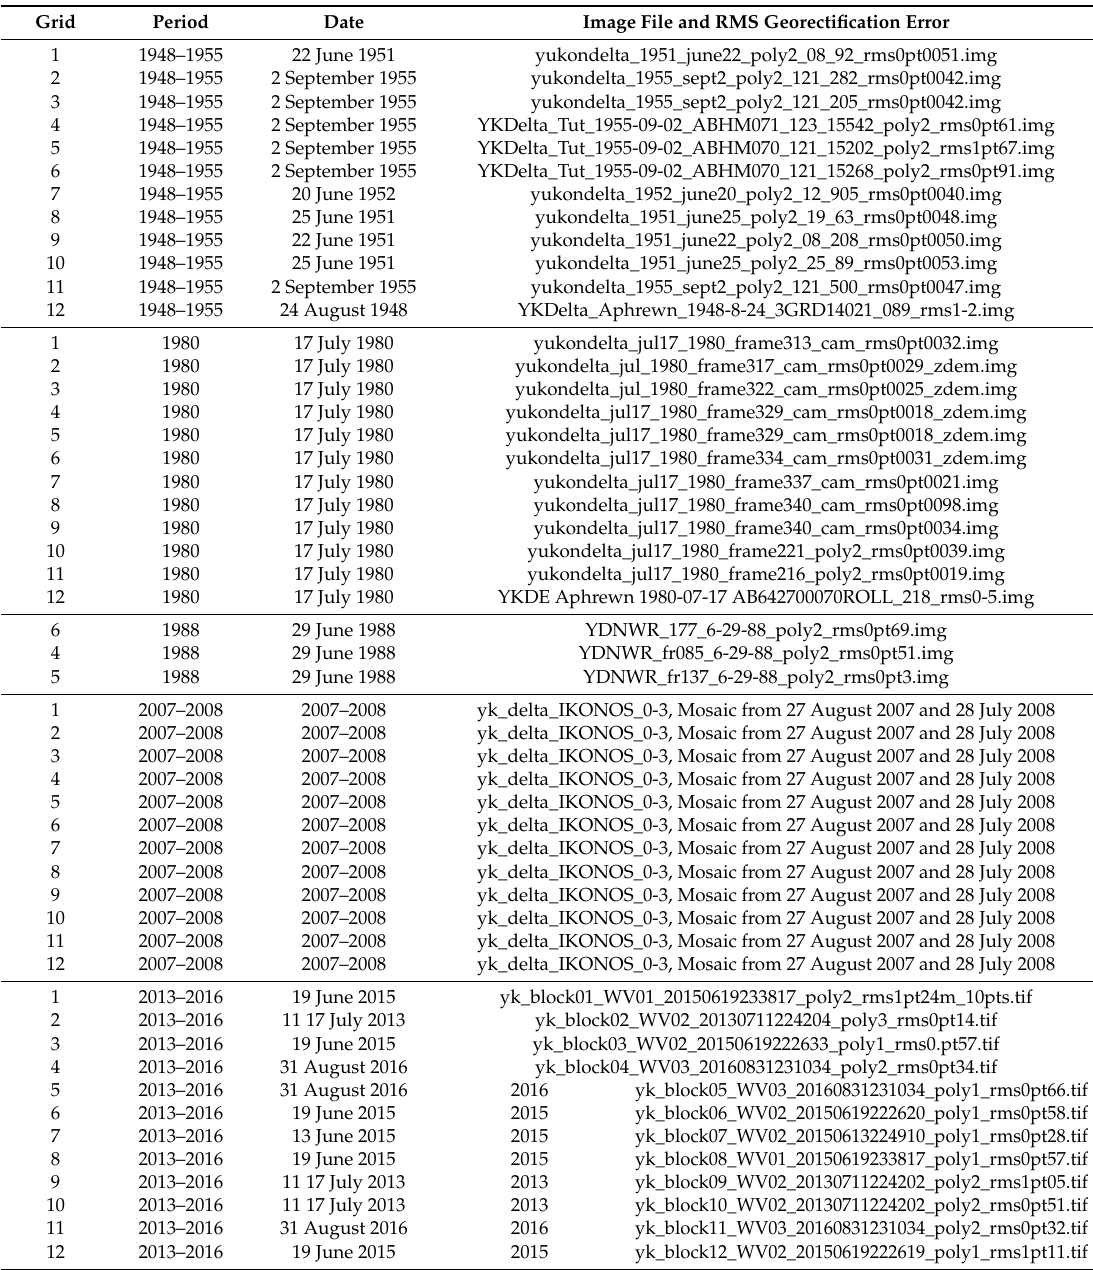
Table A1. List of images and dates used for analyzing landscape change on the YK